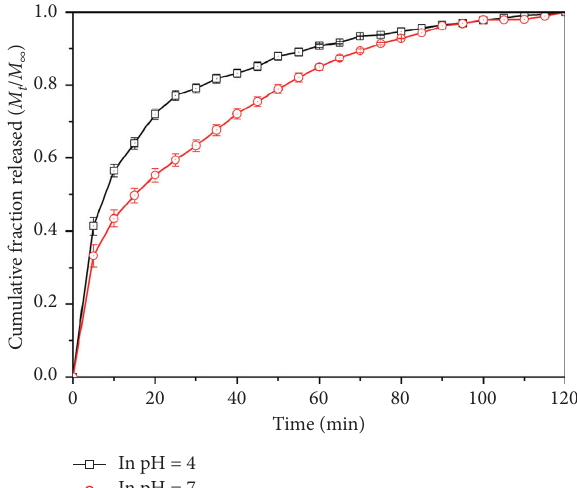
Figure 3: Cumulative fraction released profile of drug molecules in the acetate buffer solution (pH � 4) and in the phosphate buffer solution (pH � 7).